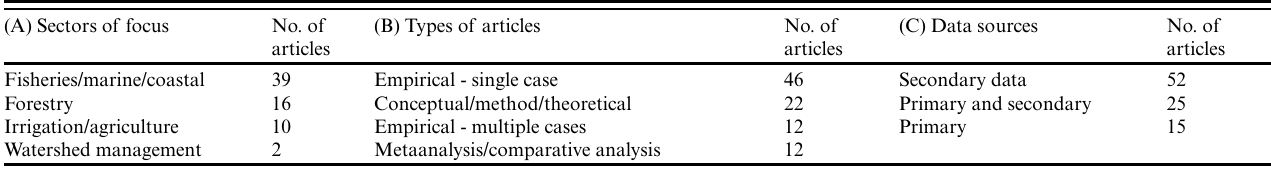
Table 3. (A) The main sectors being focused on. The total does not equal 92, because not all papers focus on a specific sector. (B) The types of articles being published. (C) The data sources used for research.